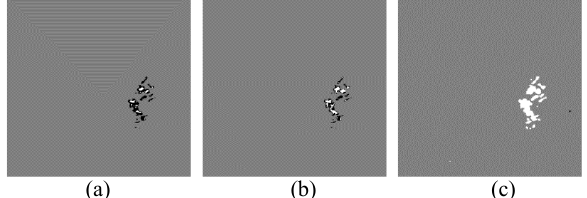
Figure 5. Change images generated by difference dual thresholds selection methods on Bern. (a) KSW-GA. (b) D- OTSU. (c) RTC.